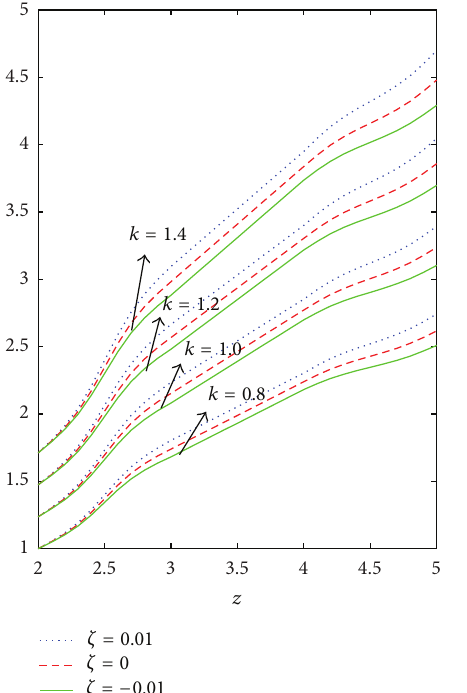
Figure 13: Variation of flow resistance ( 𝜆 ) with respect to axial distancefordifferentvaluesof 𝛿 taking 𝑛 = 0.8 , 𝑘 = 1.2 ,and 𝜏 𝑦 = 0.1